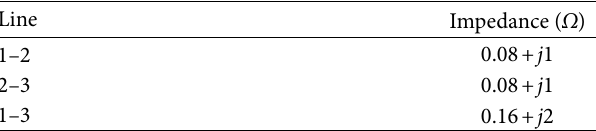
Table 1: Line data for Case 1.